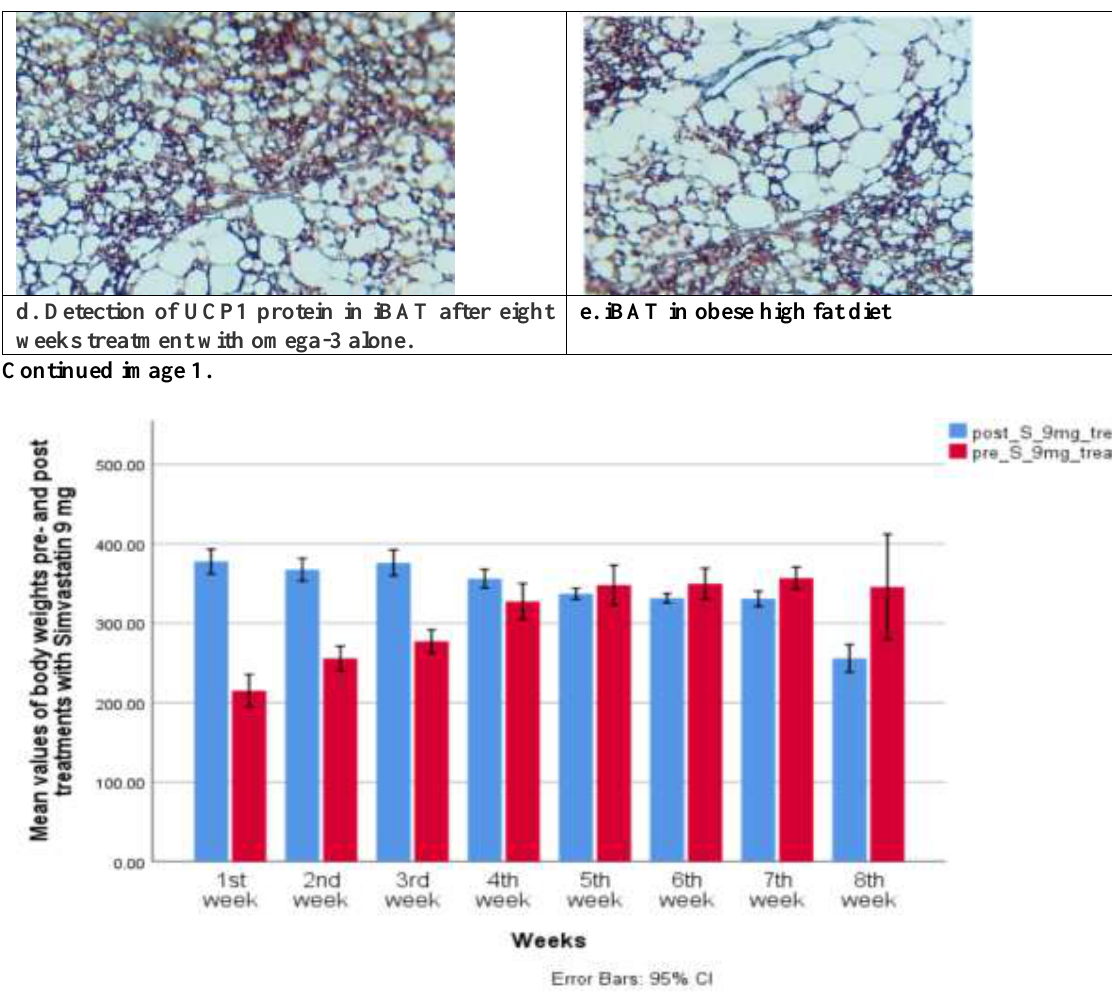
Figure 3. Demonstrate the effect of pre- and post-treatment with simvastatin 9 mg on body weights in male Wistar.